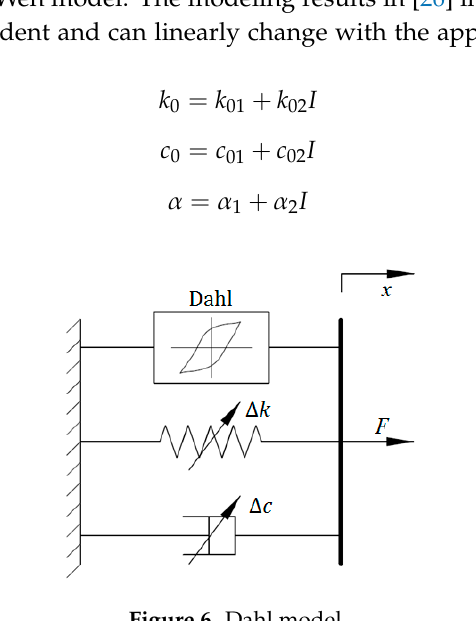
Figure 6. Dahl model.